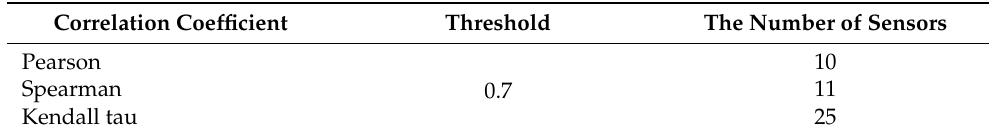
Table 4. Correlation Coefficient